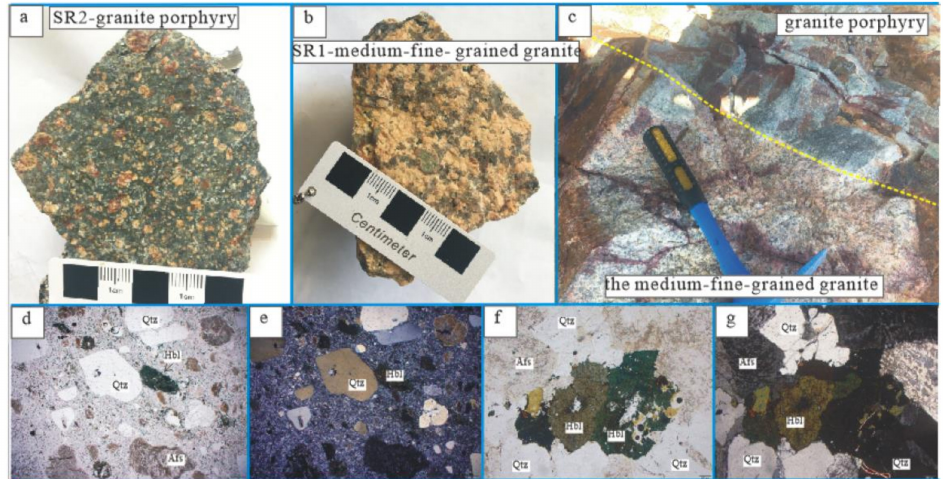
Figure 3. Filed photos, hand specimens and photomicrographs of typical rock units and ores from the Sayashk Sn deposit. ( a ) Granite porphyry with a grayish white color and a porphyritic structure; ( b ) the medium-fine-grained granite with a grayish white color and a medium-fine-grained structure; ( c ) intrusive contact relationship between granite and granite porphyry; ( d , e ) granite porphyry under single polarizer and orthogonal polarizer, respectively; ( f , g ) medium-fine-grained granite under single polarizer and orthogonal polarizer,